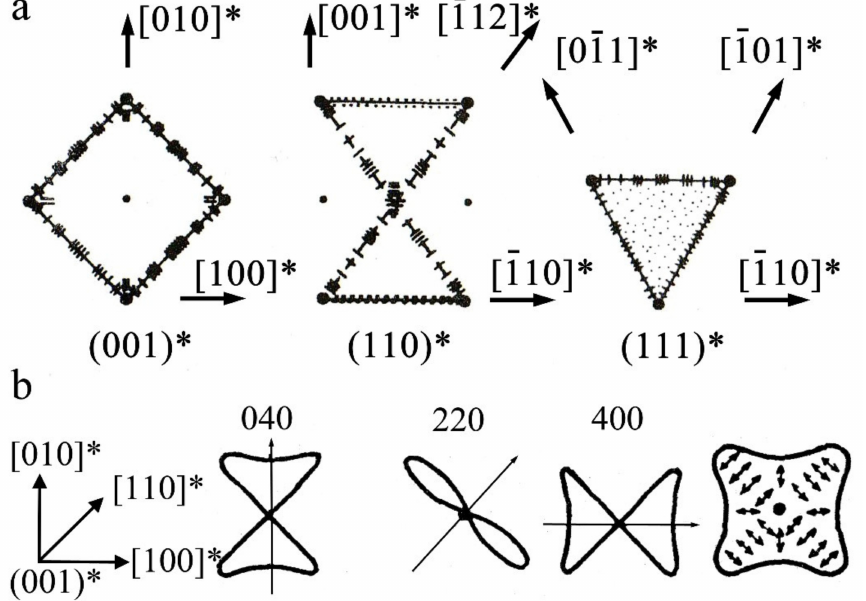
Figure 5. ( a ) Spectra of waves of atomic displacements in the form of the planar cross sections (001)*, (110)*, and (111)* of reciprocal k space and ( b ) in vicinity of reciprocal lattice nodes in the (001)* planes.